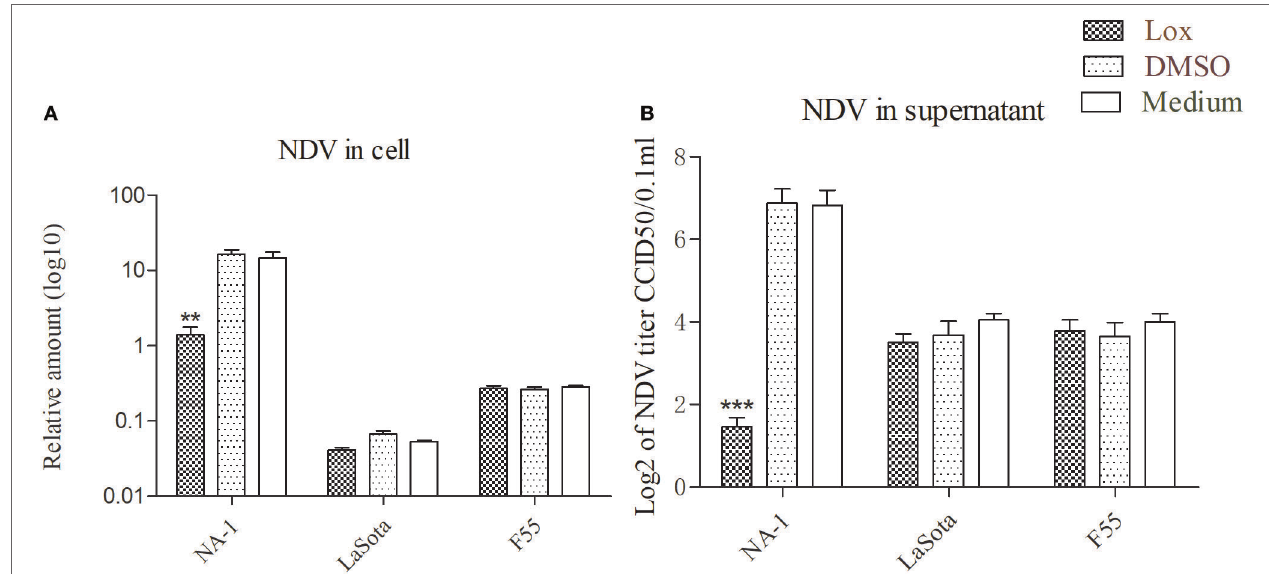
FigUre 5 | TLR7 agonist inhibit virulent Newcastle disease virus (NDV) rather than lentogenic virus replication in chicken macrophages. HD11 cells were pretreated with 1 mM loxoribine for 6 h and followed treated with three different virulence and genotypes NDV strains at 2 multiplicity of infection for 48 h; thereafter, viral genome amount in the cells and virus titer in the supernatants were measured by qPCR and micro-HA method, respectively (a,b) . All qPCR data were normalized to the geometric mean of cellular endogenous genes β -actin and hydroxymethylbilane synthase and calculated using the 2 −Δ Ct method. All values are shown as mean ± SEM ( n = 4–6) and differences were considered significant if * P < 0.05, ** P < 0.01, *** P < 0.001 as compared to the respective control (untreated) cells. All data are representative of at least two independent